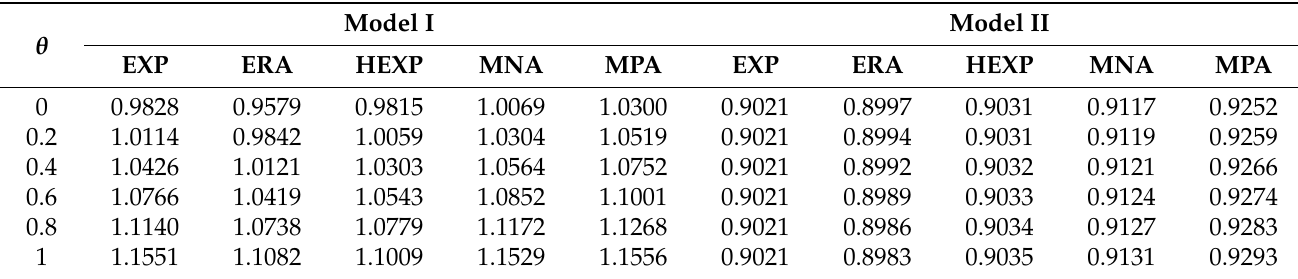
Table 7. Effect of θ on expected waiting time of P 1 customers in the system (when L = 3).